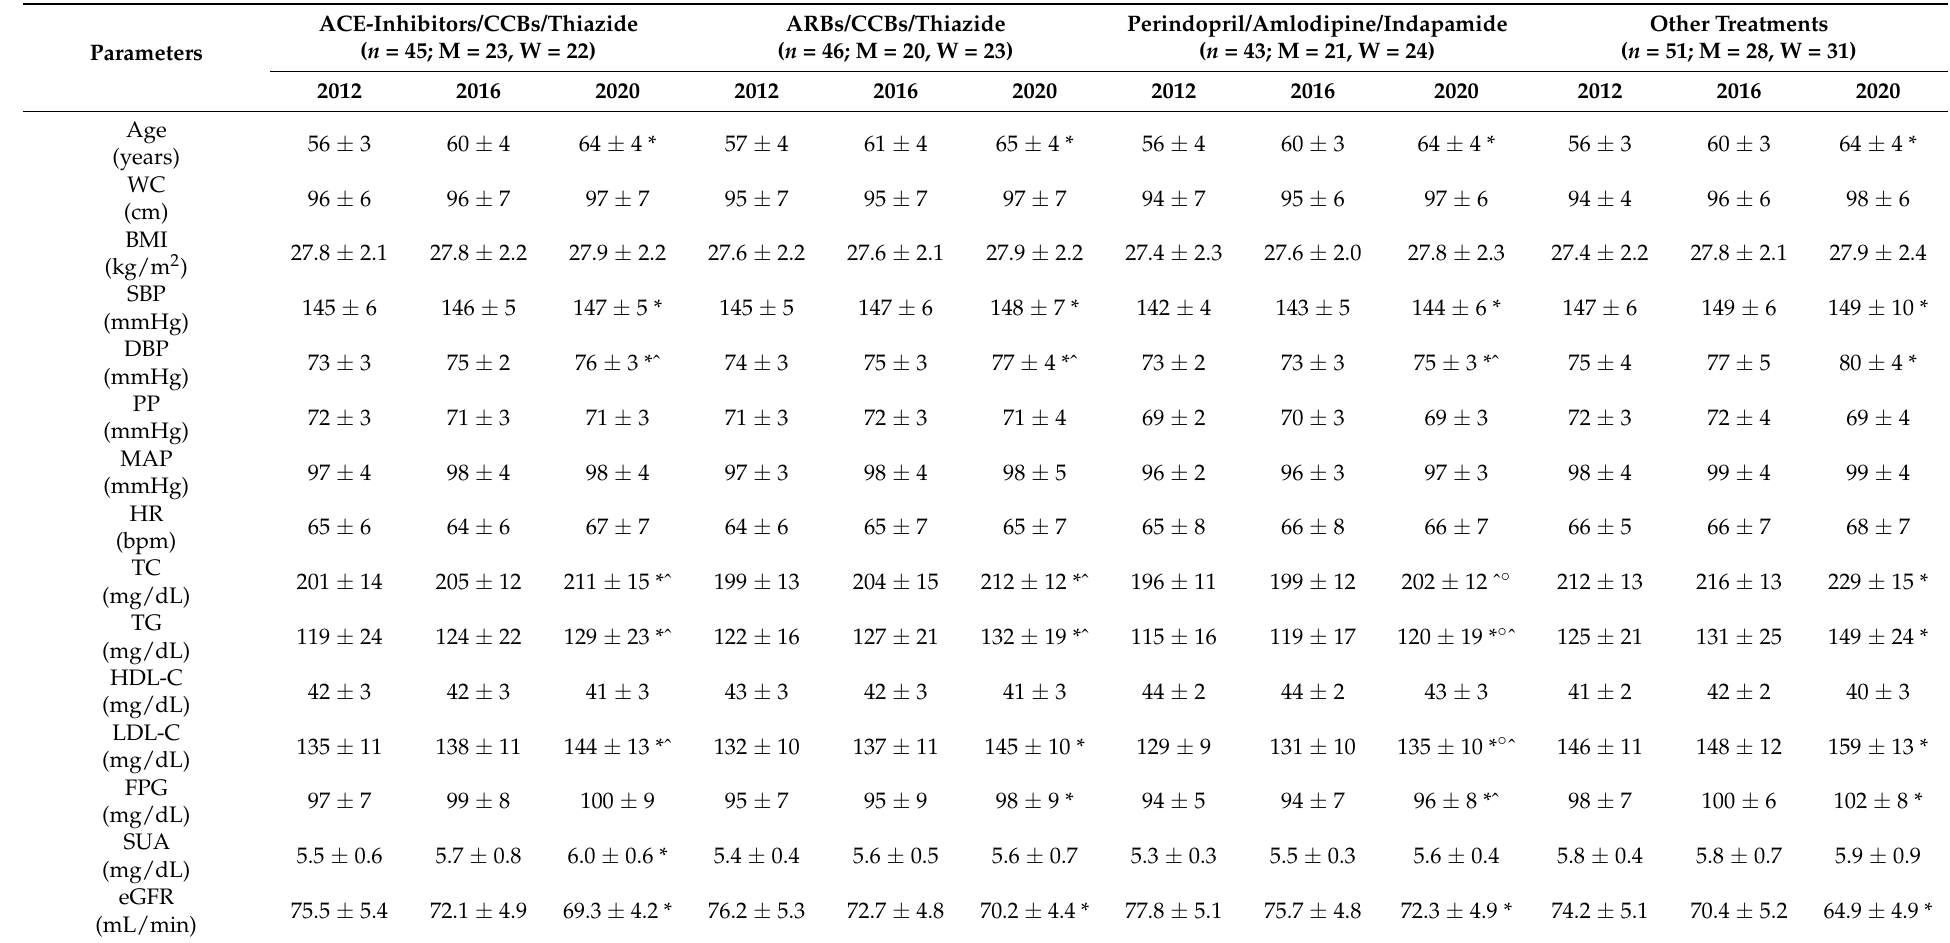
Table 1. Clinical and laboratory characteristics of the hypertensive patients included in the Brisighella Heart Study